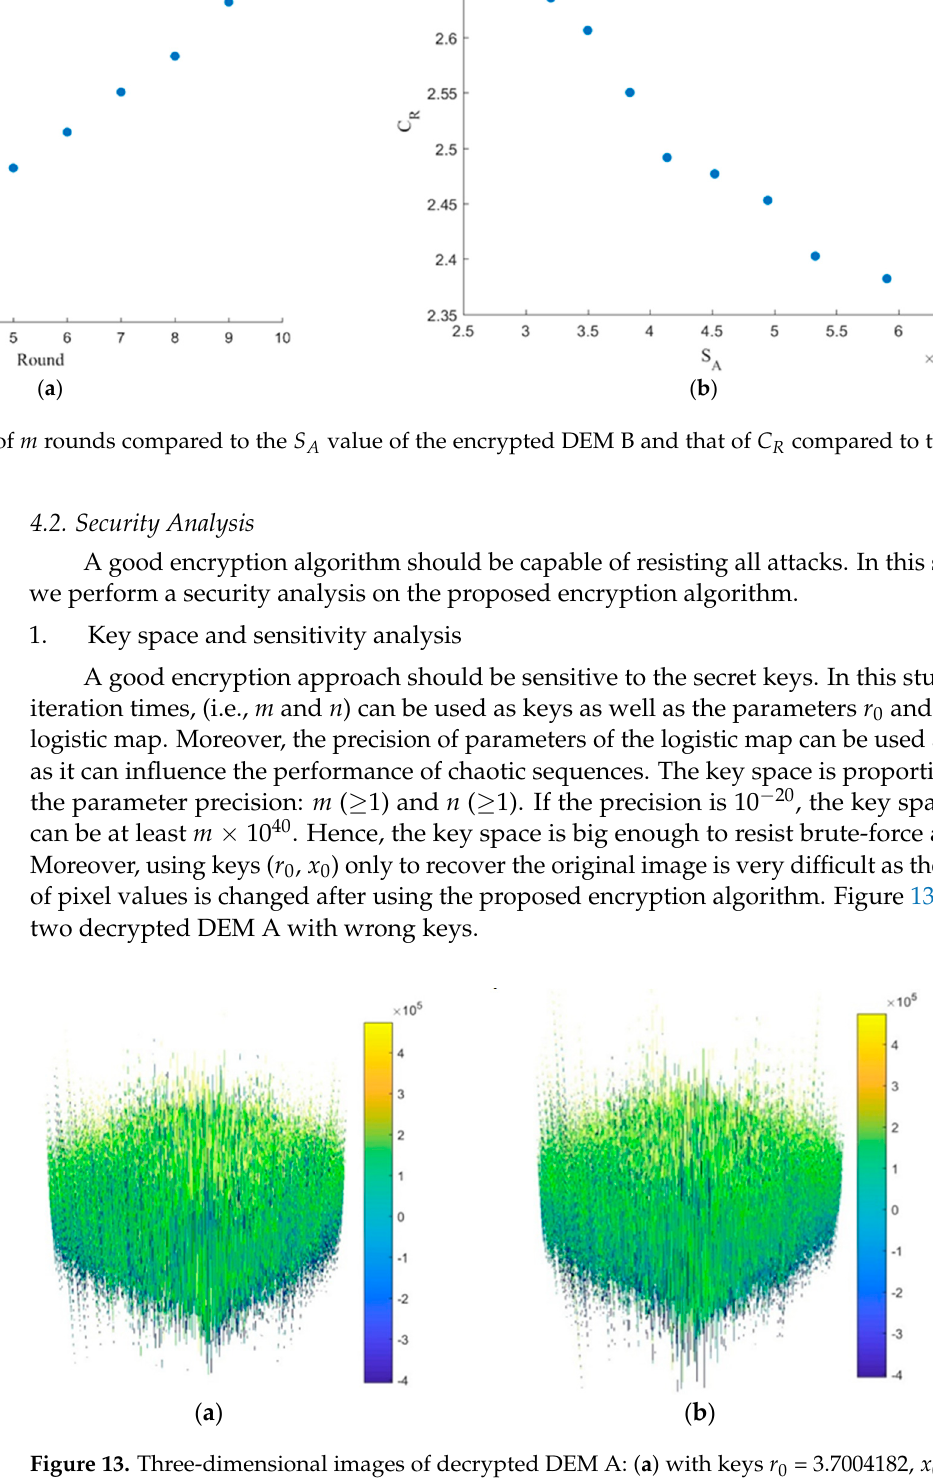
Figure 11. Three-dimensional images of encrypted DEM B. The numbering sequence is consistent with the encryption round.